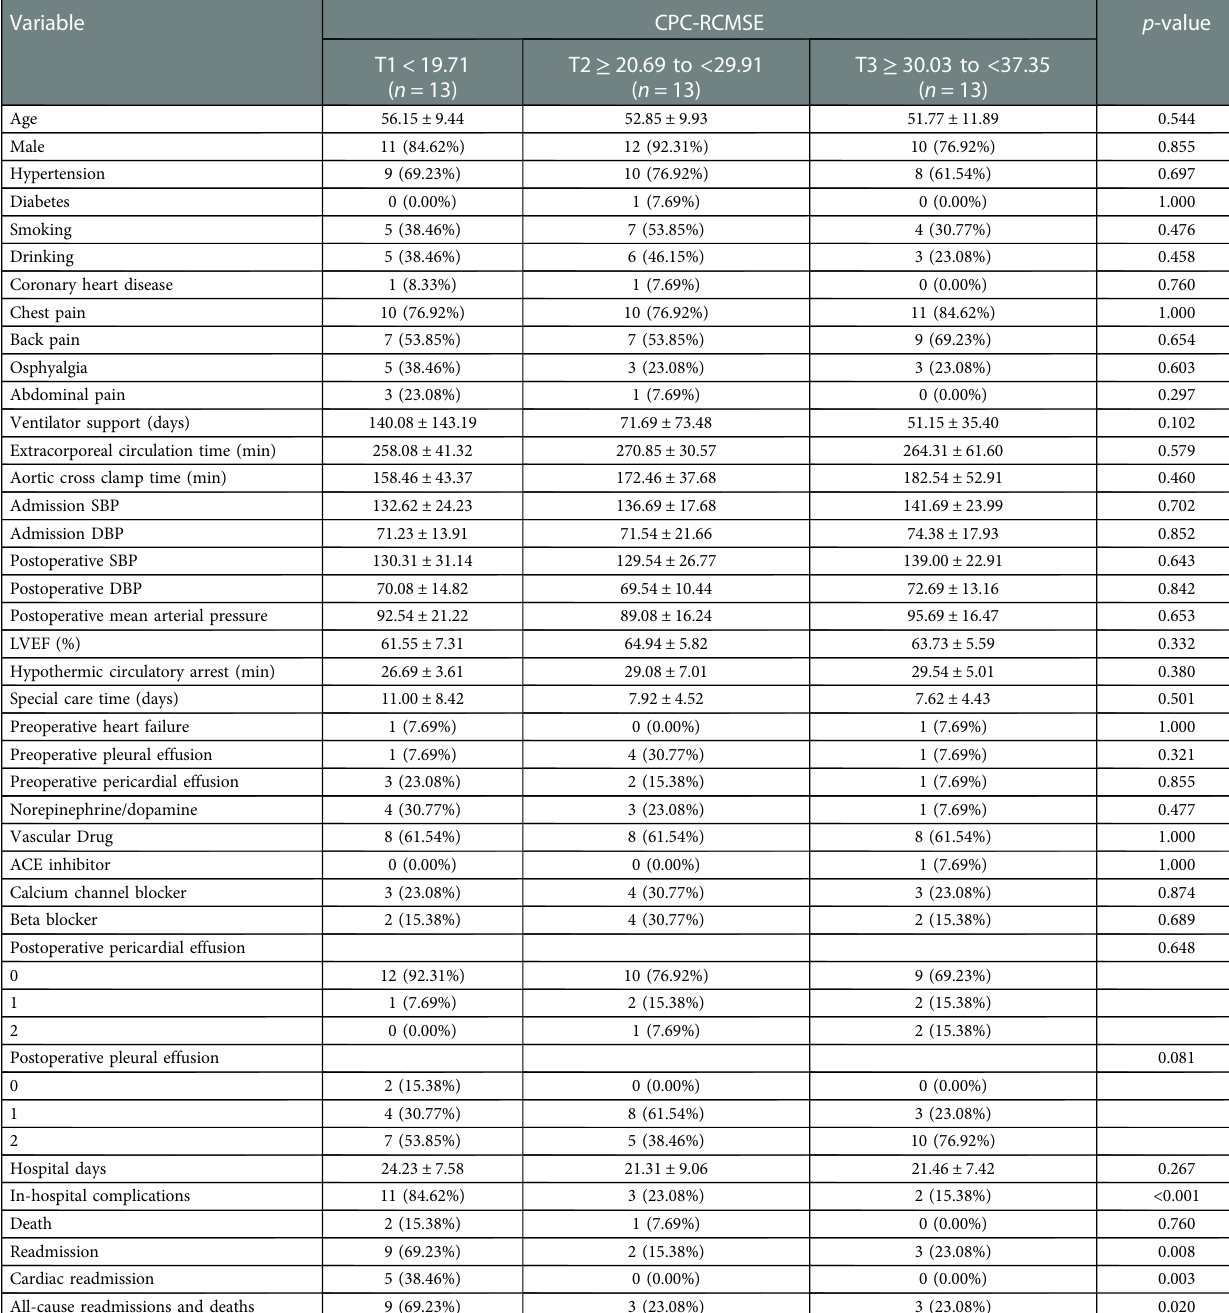
TABLE 1 Baseline characteristics of aortic dissection